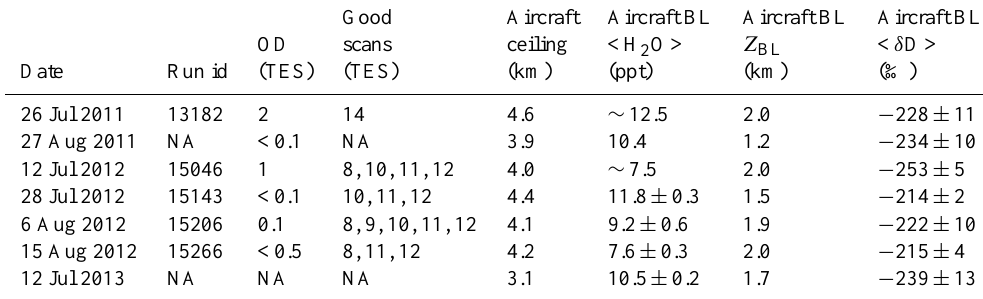
Table 1. Summary of aircraft flights and collocated Aura TES special observations over the Alaskan interior boreal forest near 64.5 ◦ N, 148 ◦ W. Average cloud effective optical depth (CloudOD) is from the nearest TES retrieval. The TES scans that have good quality (DOFS>1.1) and spatial overlap with the aircraft flight path are shown in the “good scans” column. The height of the boundary layer ( Z BL ) is defined here as the level at which water vapor drops 10% below the boundary layer mean value. Boundary layer (BL) mean water vapor (<H 2 O>) in parts per thousand (ppt), and mean δ D (< δ D>) are measured by a Picarro isotopic water analyzer onboard the Navion L-17a aircraft. Two of these aircraft flights (27 August 2011 and 12 July 2013) did not have coincident TES special observations. Good Aircraft OD scans Run id